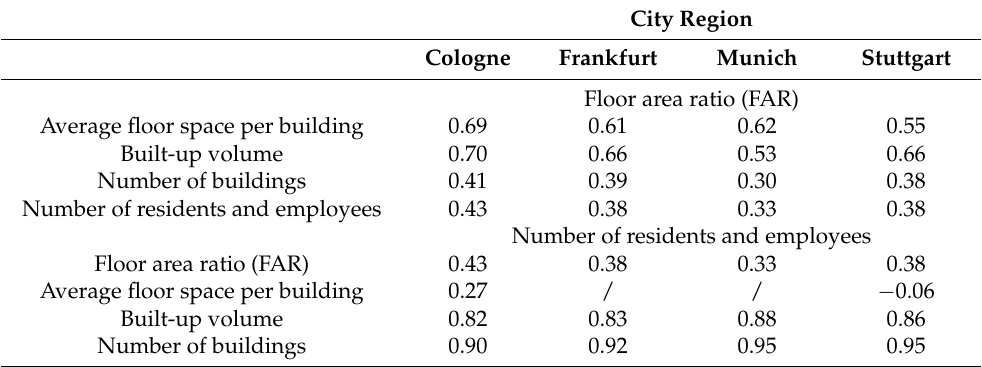
Table 3. Spearman’s rank correlation coefficients for several density measures.